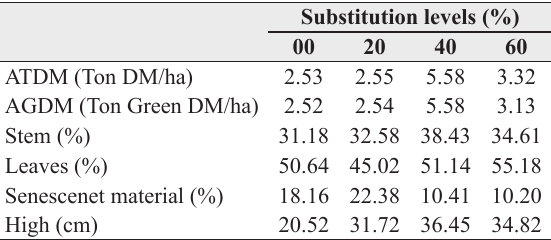
Total availability of dry matter (ATDM) of forage, availability of green dry matter (AGDM), percentages of steam, leaves, senescent material and forage high (cm).